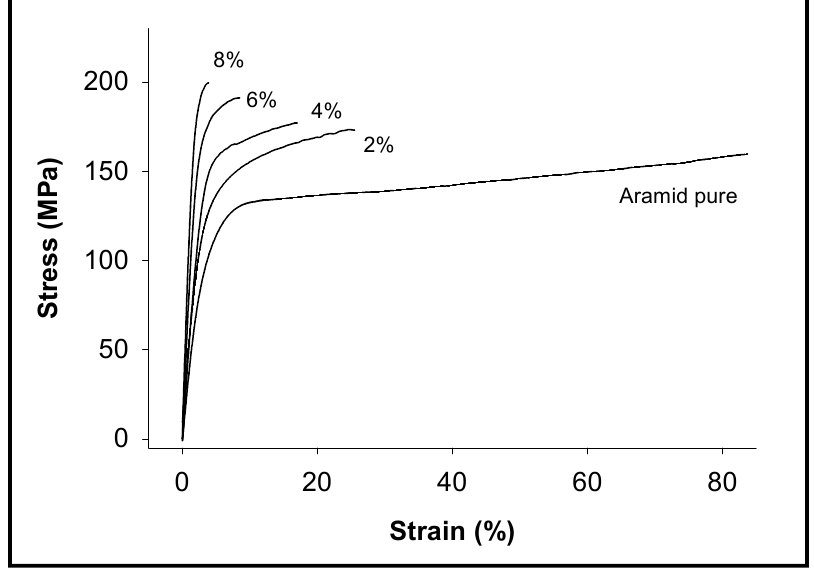
Figure 11. Stress-strain curves for the ArGrO composites with different Wt.% of GrO.